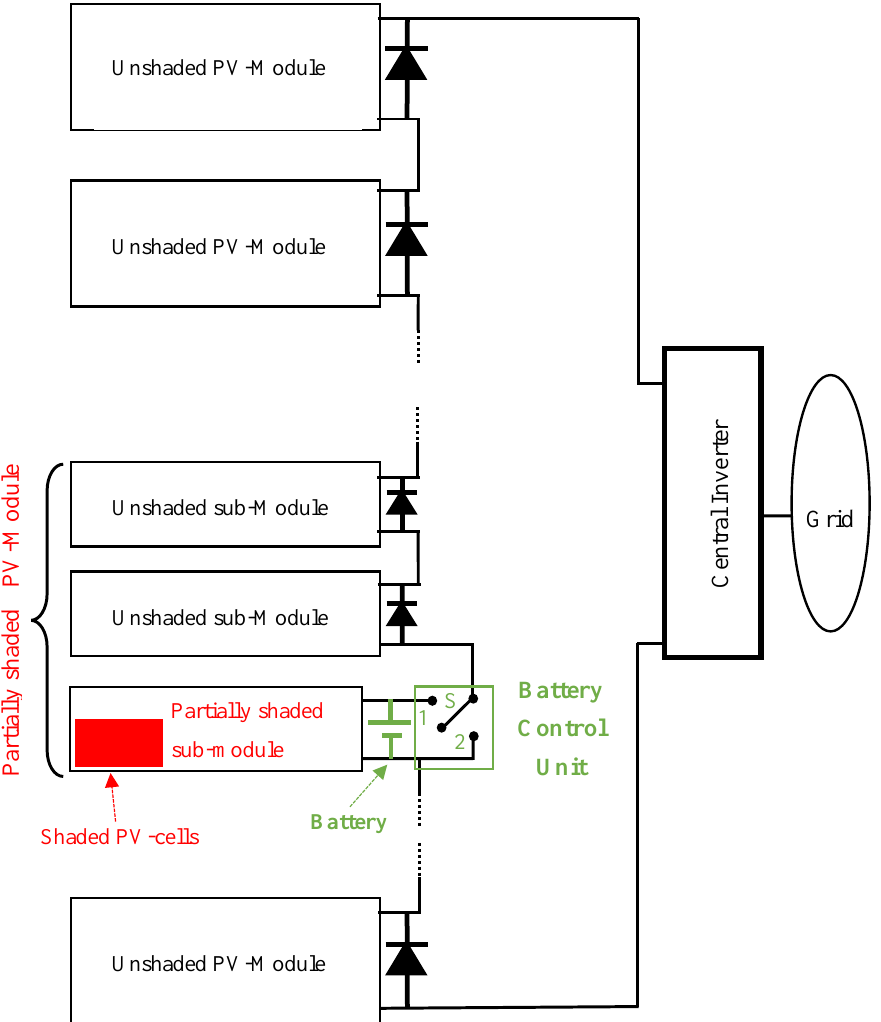
Figure 2. Architecture of the proposed PV plant in the presence of a partially shaded sub-module. 143